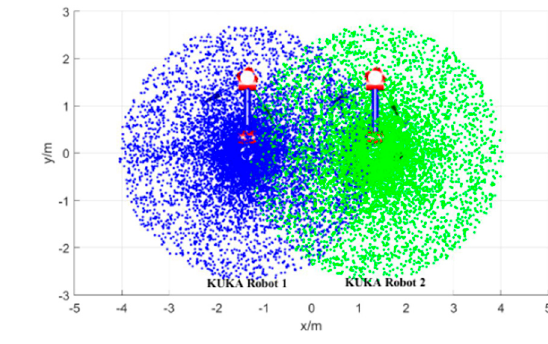
of the robot is L r = A’B’ = C’D’ = E’F’ = G’H’ = R i . In modeling, the vertical y-direction line spacing